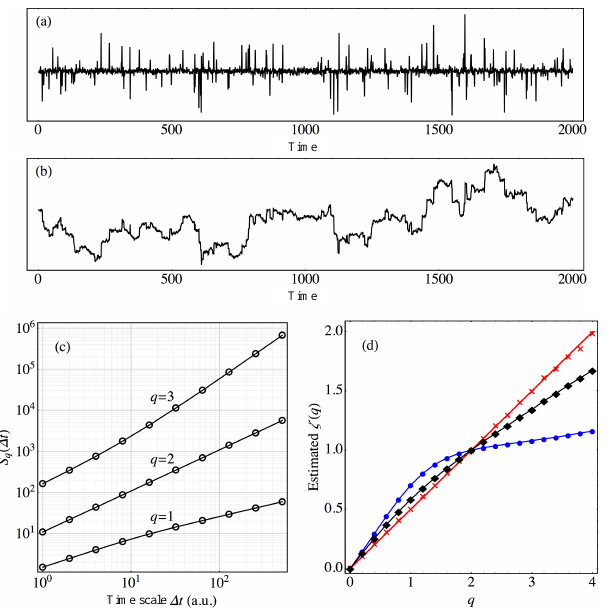
Figure 6. As Fig. 5, but for a jump-diffusion process with memory as described in Appendix C. The parameter value β = 0 . 4 is